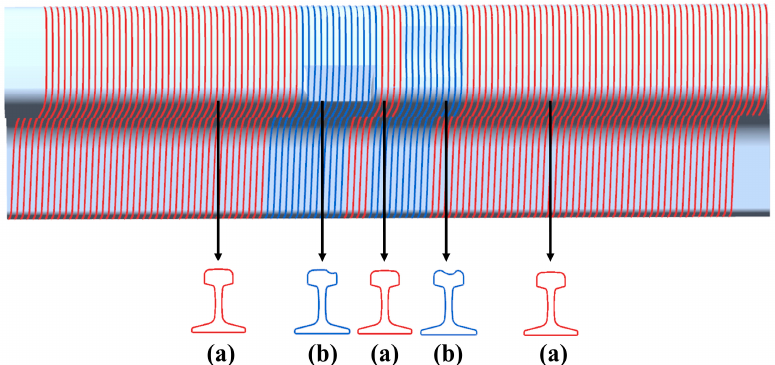
Figure 4. Geometric features of the rail profiles. ( a ) The point-cloud profiles of the undamaged areas with the same geometric features; ( b ) The point-cloud profiles of the damaged areas with a variety of shapes and no uniform geometric features.